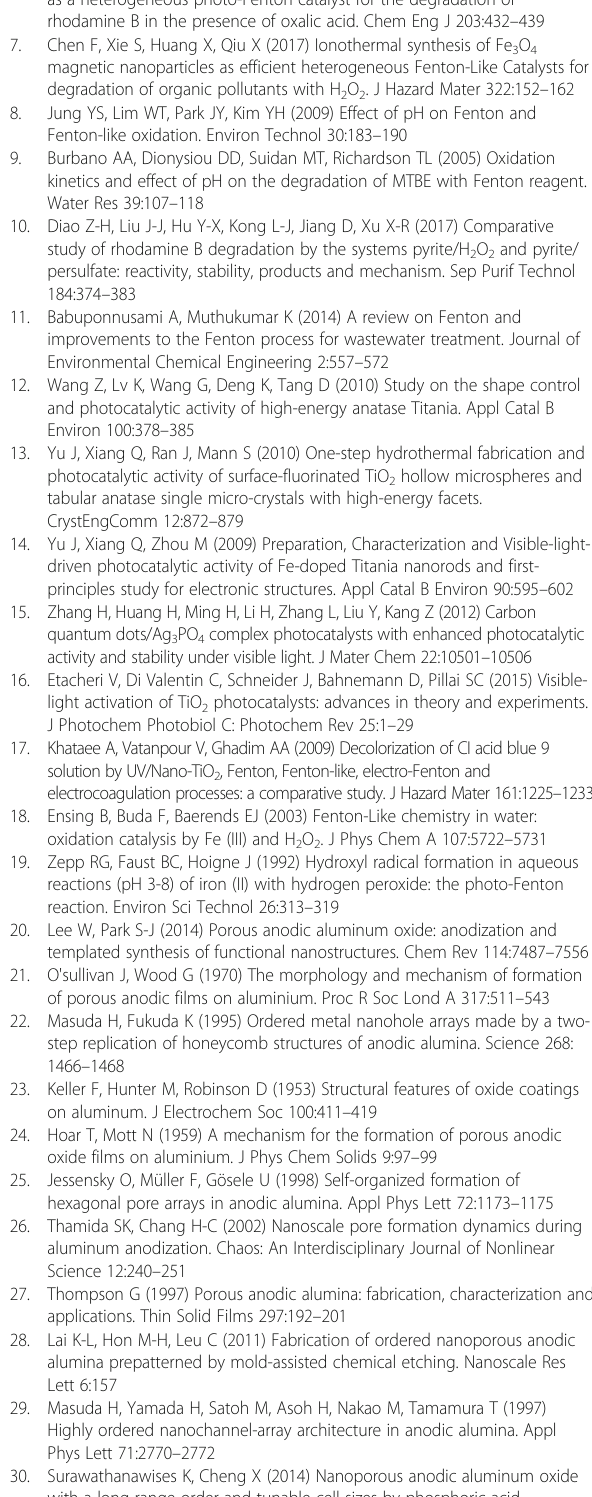
Additional file 1: Figure S1. Cross-section SEM image of 6.53 μ m long CuO NRs in AAO (scale bar: 1 μ m). Figure S2. XRD spectrum of TiO 2 cap- ping CuO NRs annealed at 600°C, over the 2 θ ranges of 25°-29°. Figure S3. Degradation results of different TiO 2 thickness annealed at 500 °C capping 1.85 μ m long CuO NR